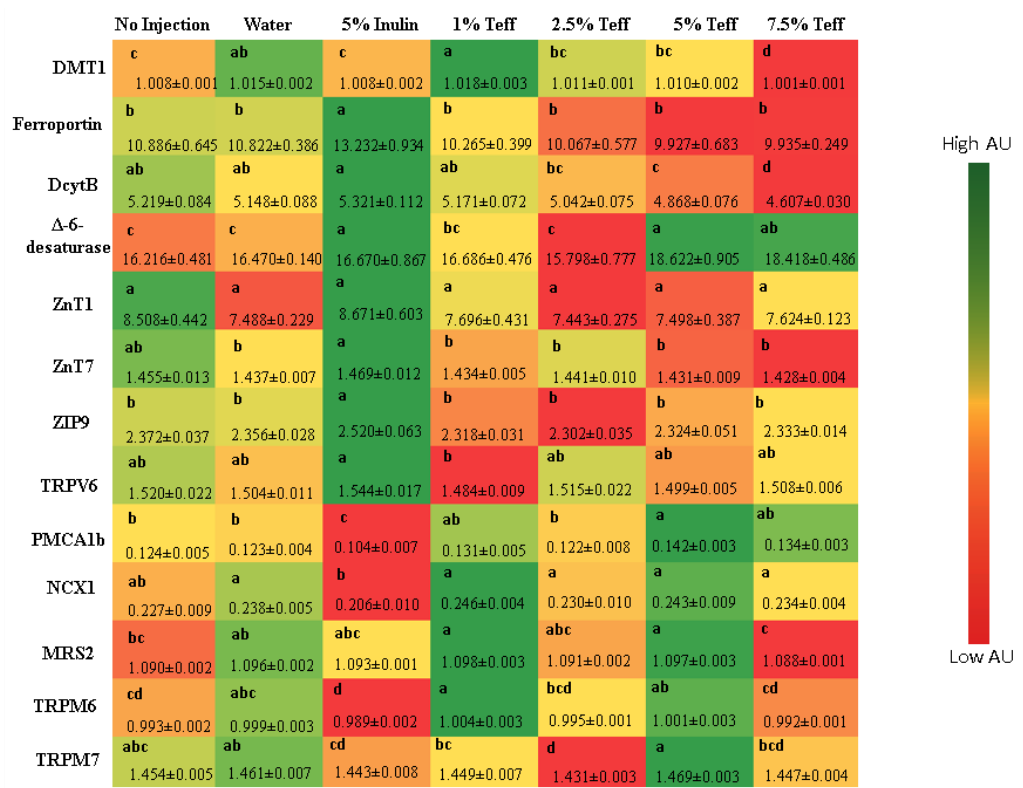
Figure 2. Effect of the intra-amniotic administration of experimental solutions on duodenal gene expression. Values are the means (AU: arbitrary units) ± SEM, n = 8. a–d Per gene, treatments groups not indicated by the same letter are significantly different ( p < 0.05). DMT1, Divalent metal transporter